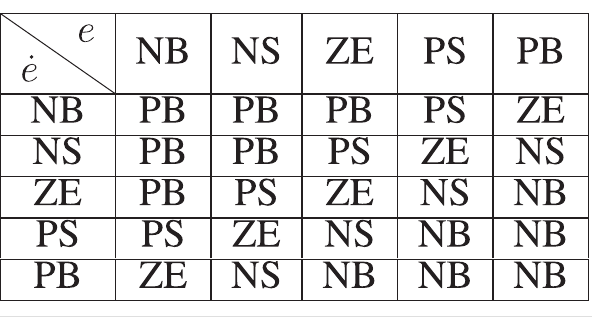
Frontiers in Robotics and AI |